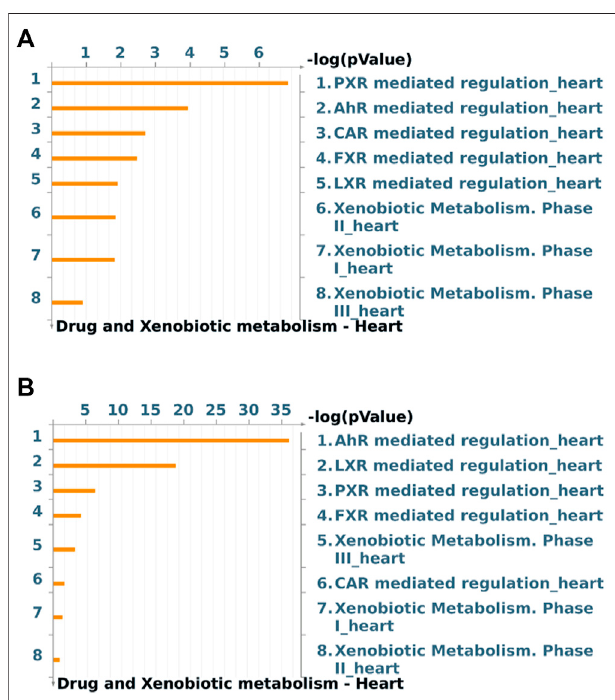
FIGURE 1 | Drug and xenobiotic metabolism pathways most signi fi cantly ( p < 0.05) regulated by 4 h Wnt5A (A) and Wnt5A/IL-1 β combination (B) treatment in HCAEC. Pathways represented as histograms are ranked by the – log value ( p value). Data are from 3 independent